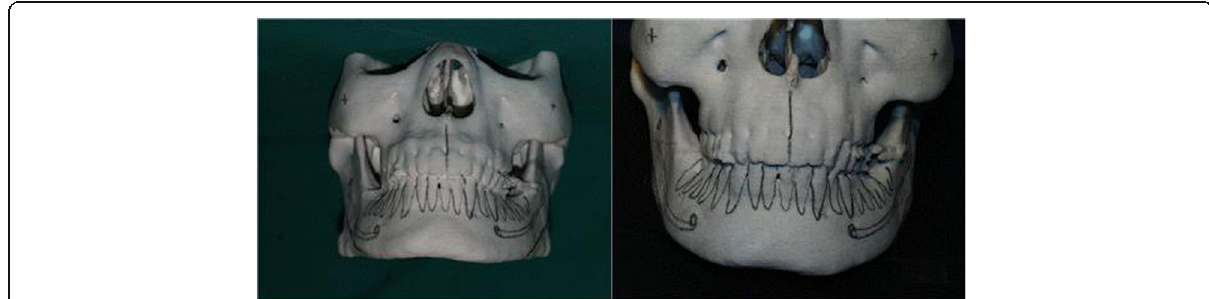
Fig. 15 Type II. Skeletal lateral projection type. Picture in the left is pre-operative 3D model, picture in the right is the post-operative picture directly performed on 3D. Angle reduction is noticed